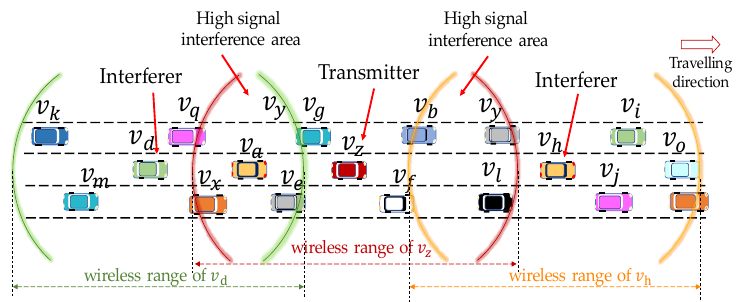
Figure 1. Hidden terminal collision scenario.